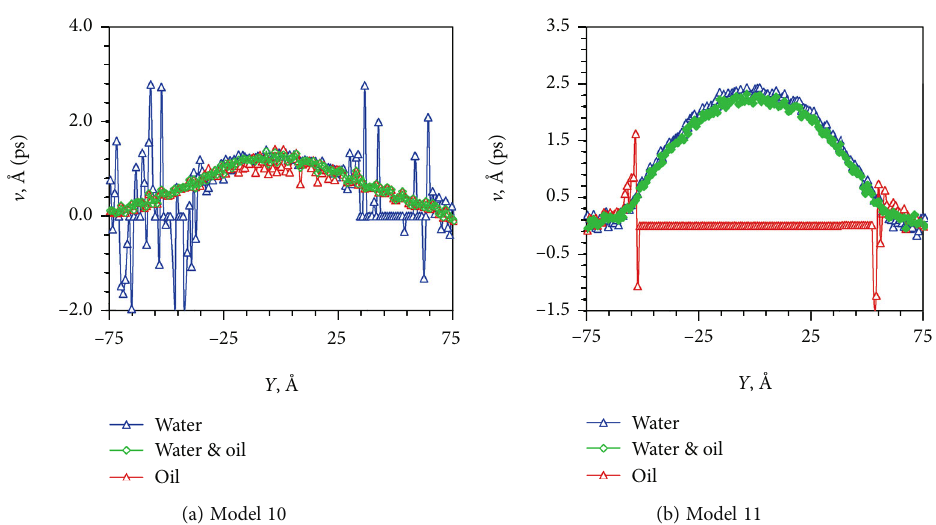
Figure 13: Velocity pro fi le along the X -axis of models of di ff erent